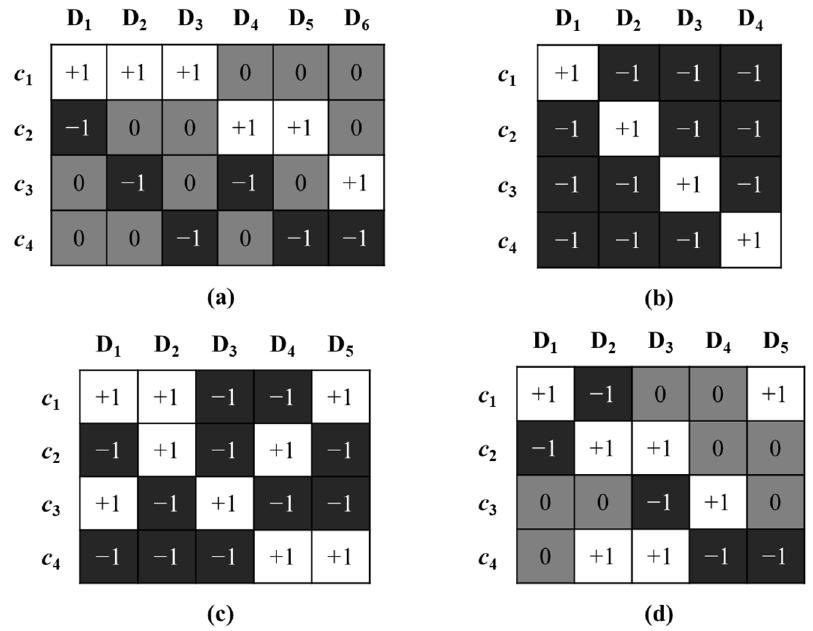
Figure 4. Coding matrices of four coding strategies under four categories: ( a ) OVO, ( b ) OVA, ( c ) DR, ( d ) SR.